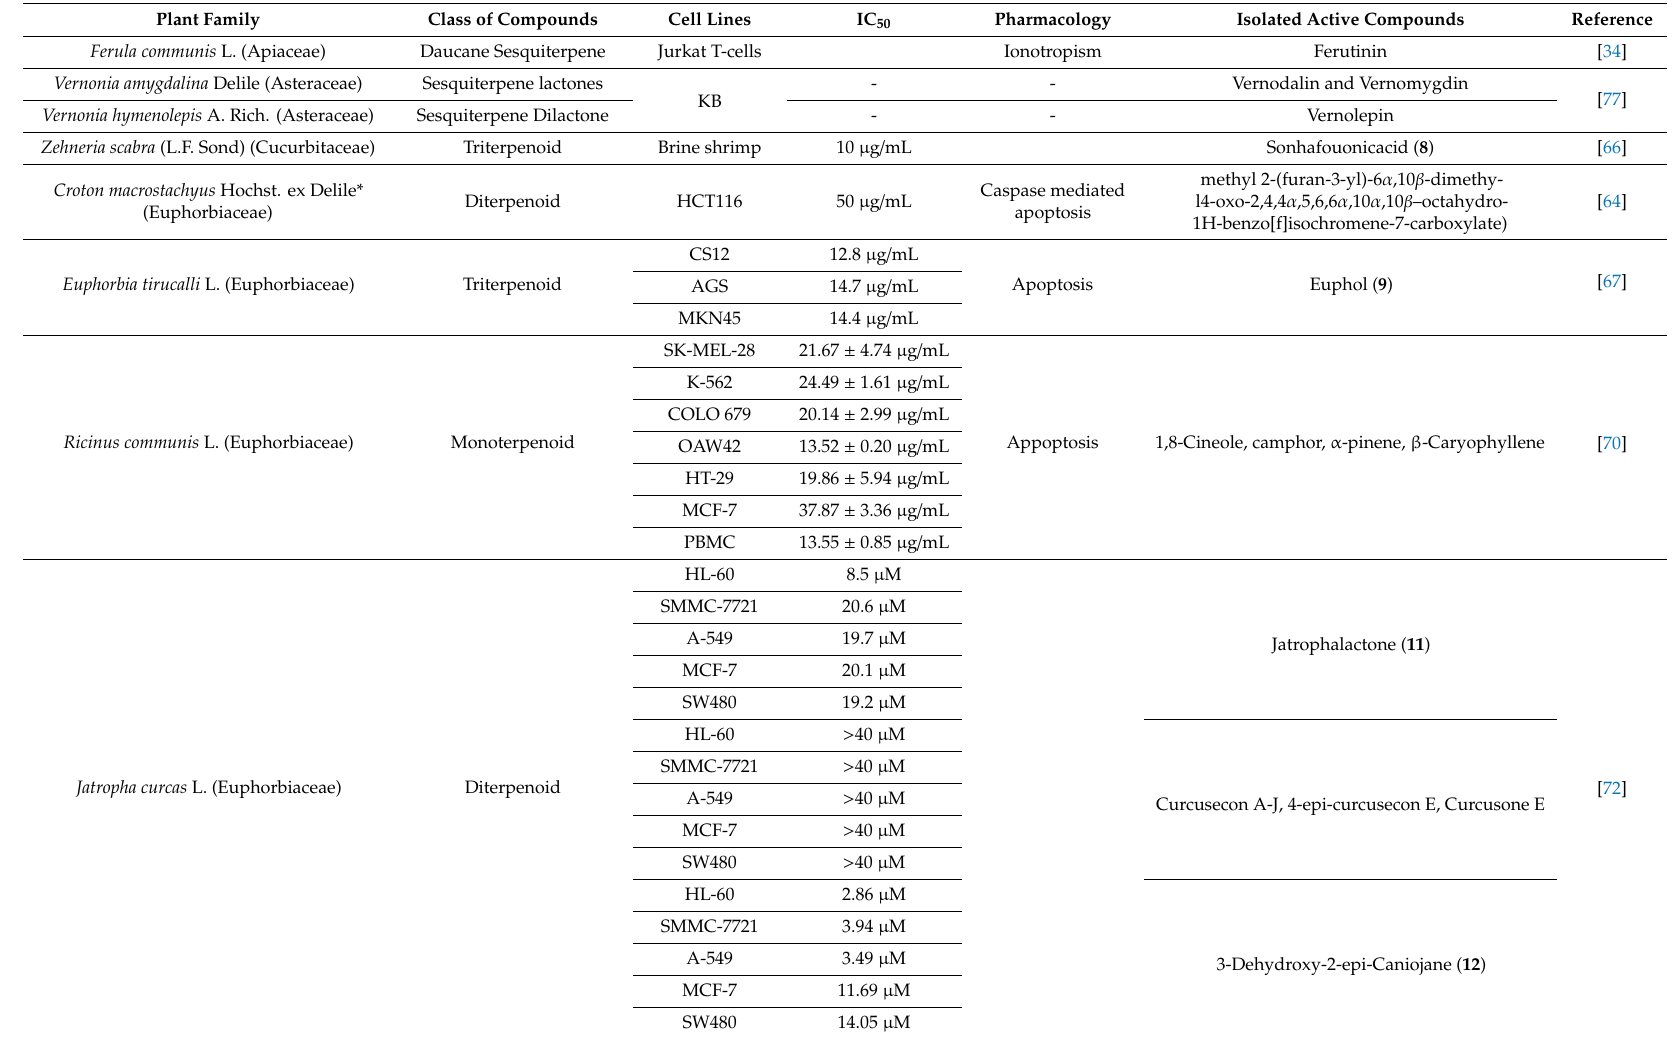
Table 2. Terpenoids isolated from medicinal plants that are traditionally used to treat cancer in